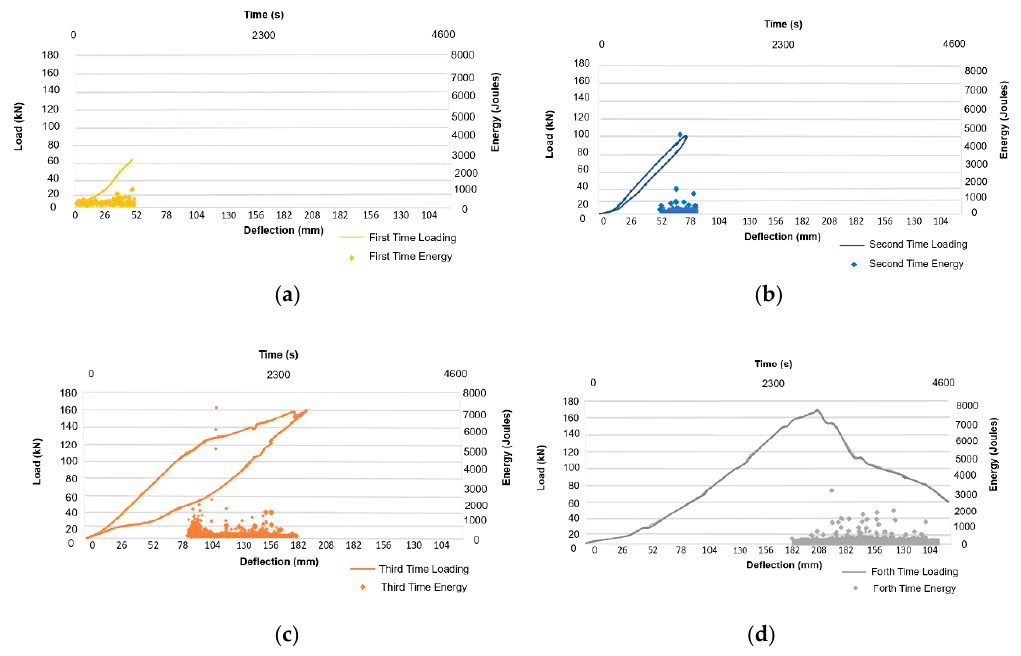
Figure 8. Load–deflection against AE energy under repeated load: ( a ) fist crack load; ( b ) 1.5 times the